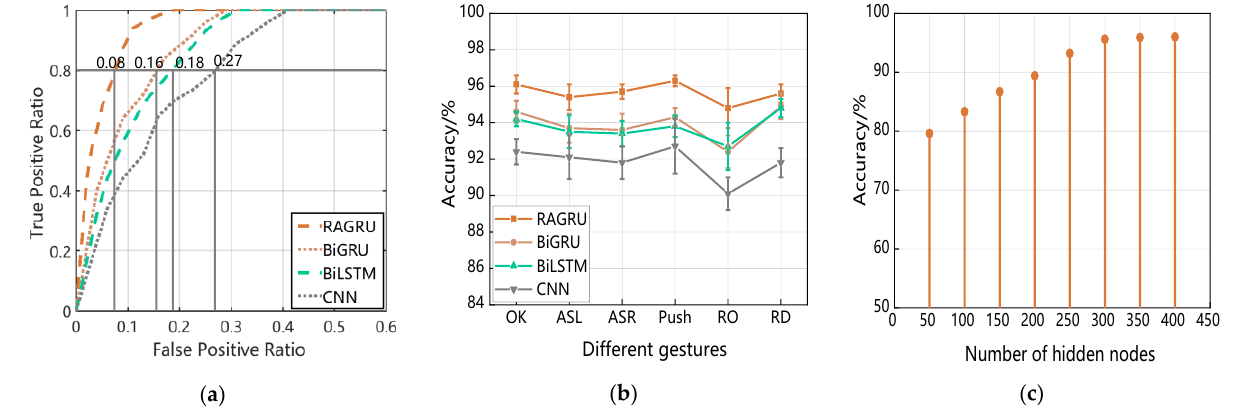
Figure 16. Algorithm performance comparison: ( a ) Comparison of feature extraction algorithms. ( b ) Impact of different feature extraction algorithms on gesture accuracy. ( c ) The effect of different numbers of hidden nodes on the accuracy of gestures.